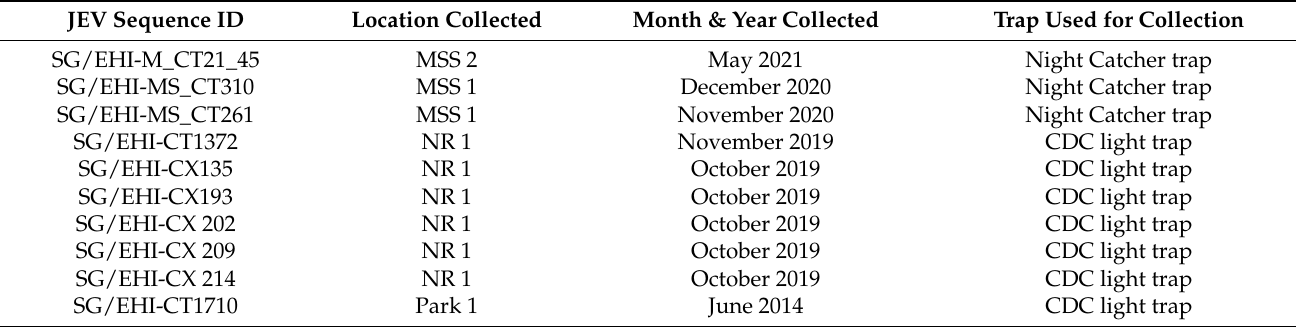
Table 2. Spatial and temporal information of the JEV-positive